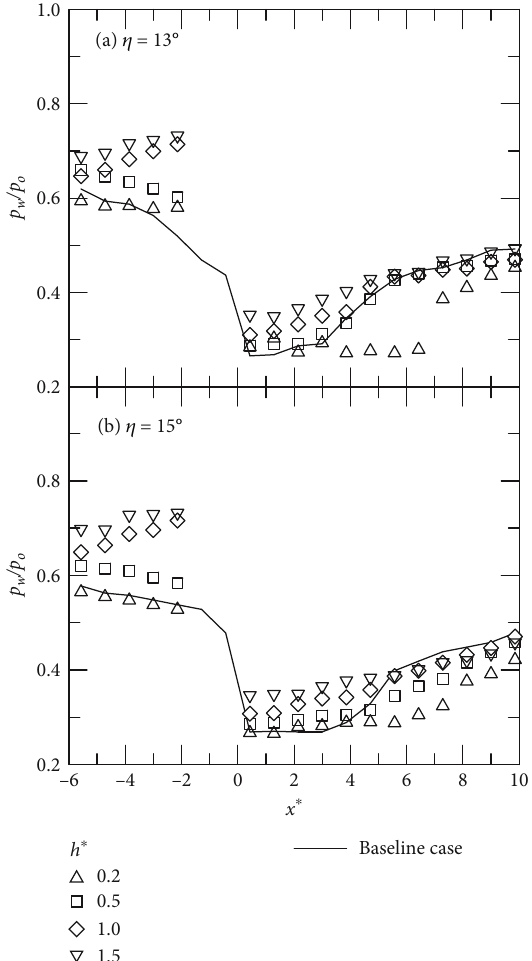
Figure 5: Mean surface pressure distribution for M = 0 : 89